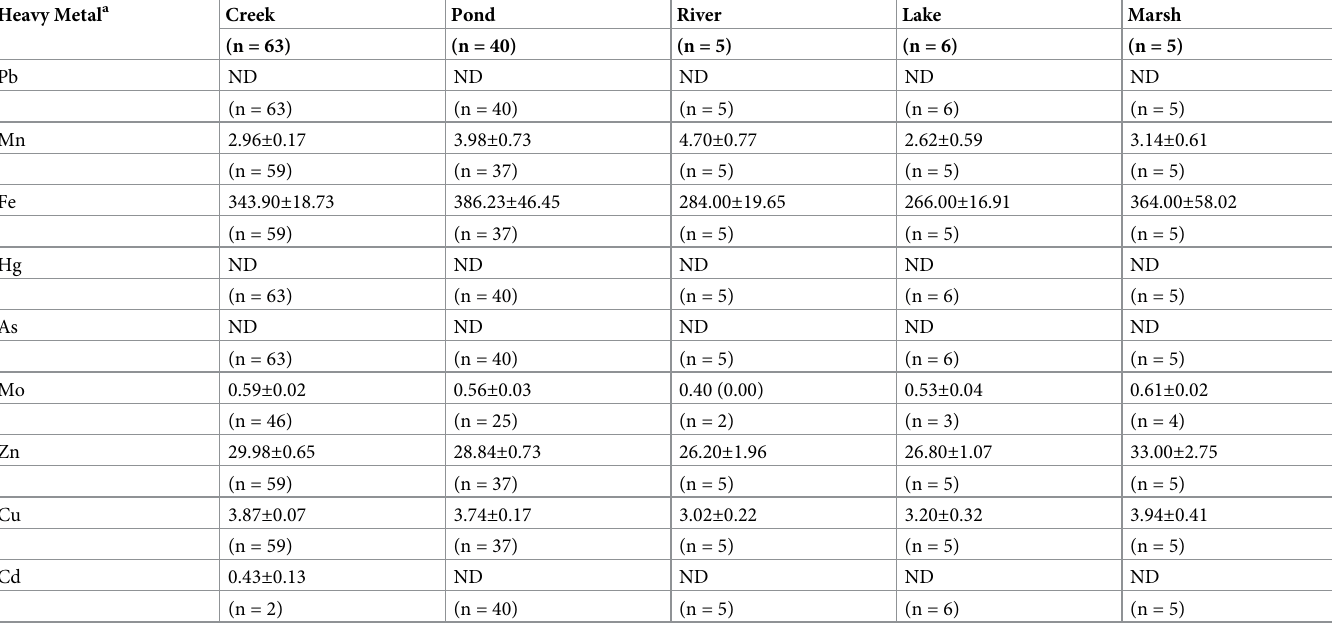
Table 5. Mean ( ± SE ) liver concentrations (ppm, wet weight) for heavy metals from muskrats ( Ondatra zibethicus ) harvested in different water body types. Heavy Metal a